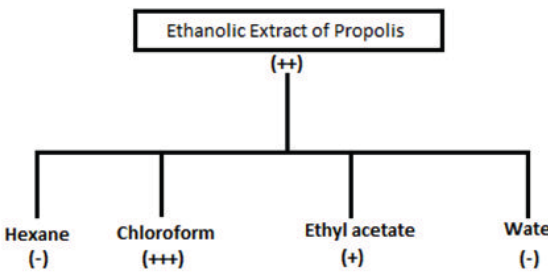
Figure 1 - Representative flowchart of the fractionation process of the ethanolic extract of propolis (eeP) with solvents of different polarities and activities of the fractions against P. aphanidermatum . (-) no activity; (+) weak activity; (++) good activity; and (+++) high activity against P. aphanidermatum phases coexist at room temperature (Husen et al.